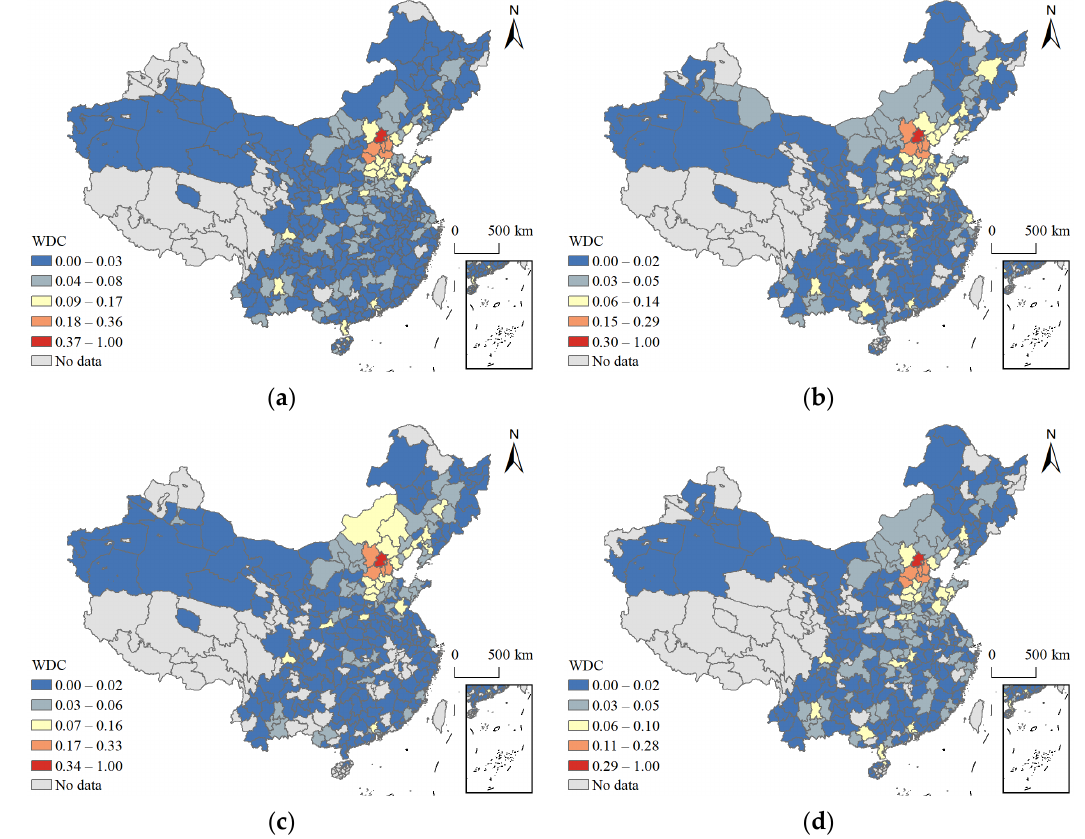
Figure 6. Spatial distribution of city importance in four seasons s: ( a ) spring; ( b ) summer; ( c ) autumn; ( d ) winter.